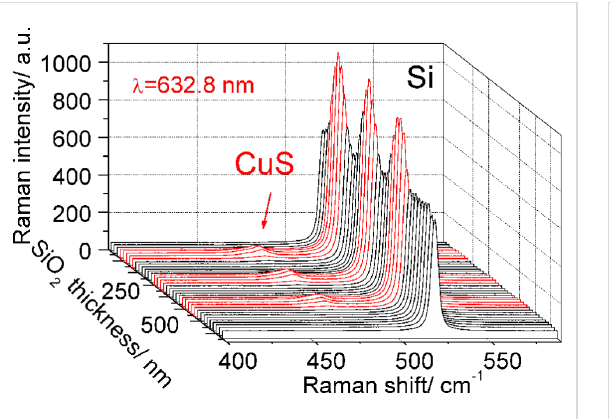
Figure 3: The dependence of the IERS enhancement factor of phonon modes in CuS NCs on the thickness of the SiO 2 layer determined for laser excitation lines at 632.8, 514.5, and 325